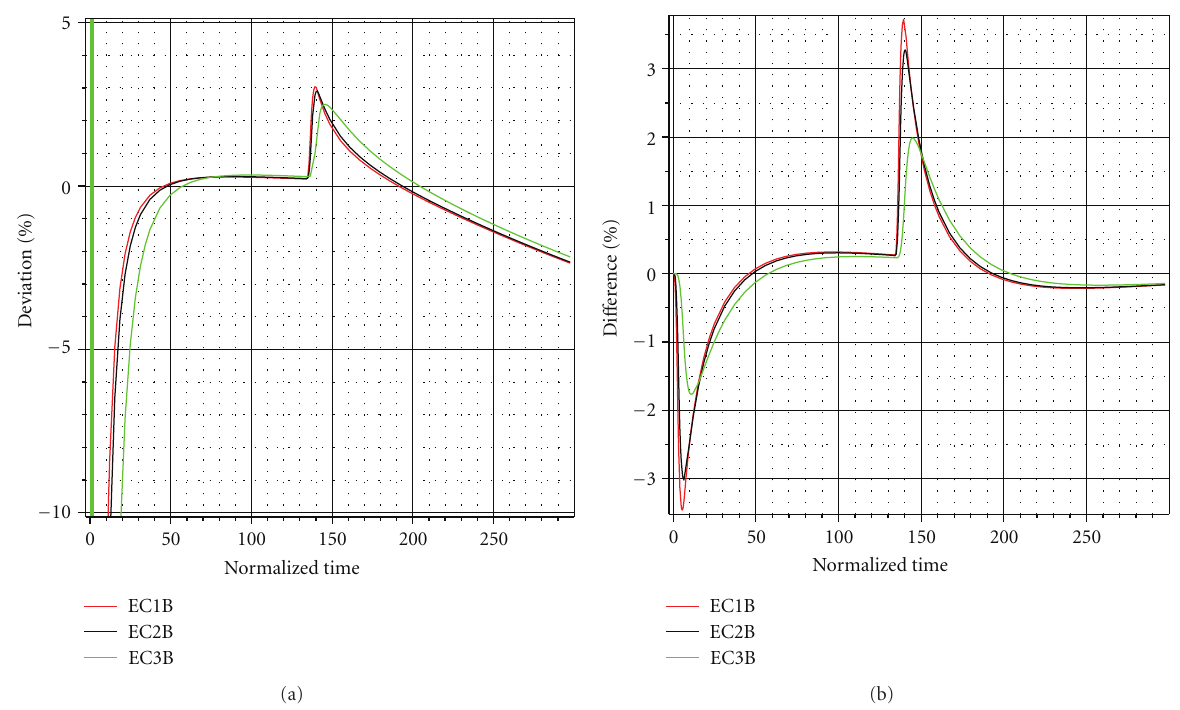
− Φ di ff usion ) between 1